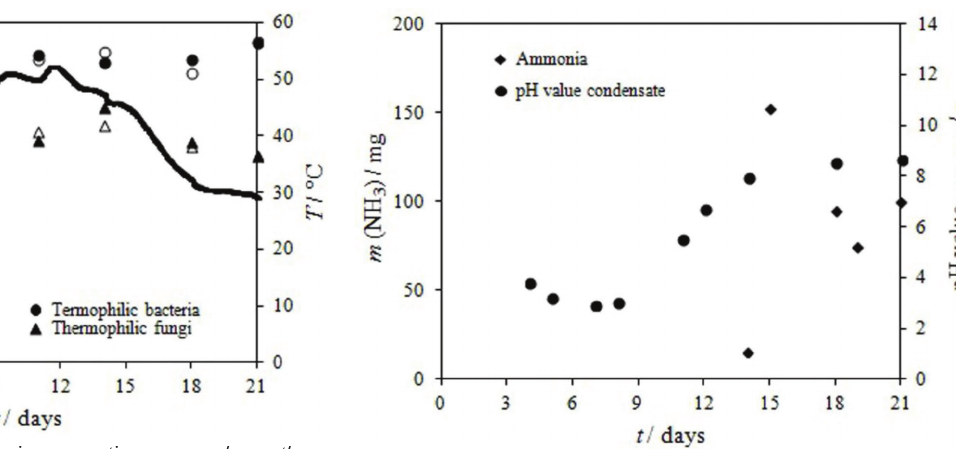
Fig. 2 – Temperature changes in composting mass and growth of microorganisms over 21 days of composting